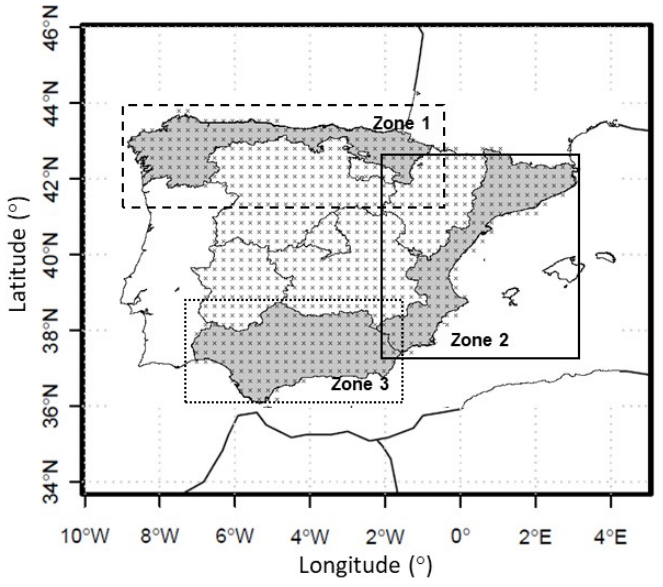
Figure 1. Map of location of 906 sites and study zones (Zone 1, Zone 2, and Zone 3) of continental Spain.